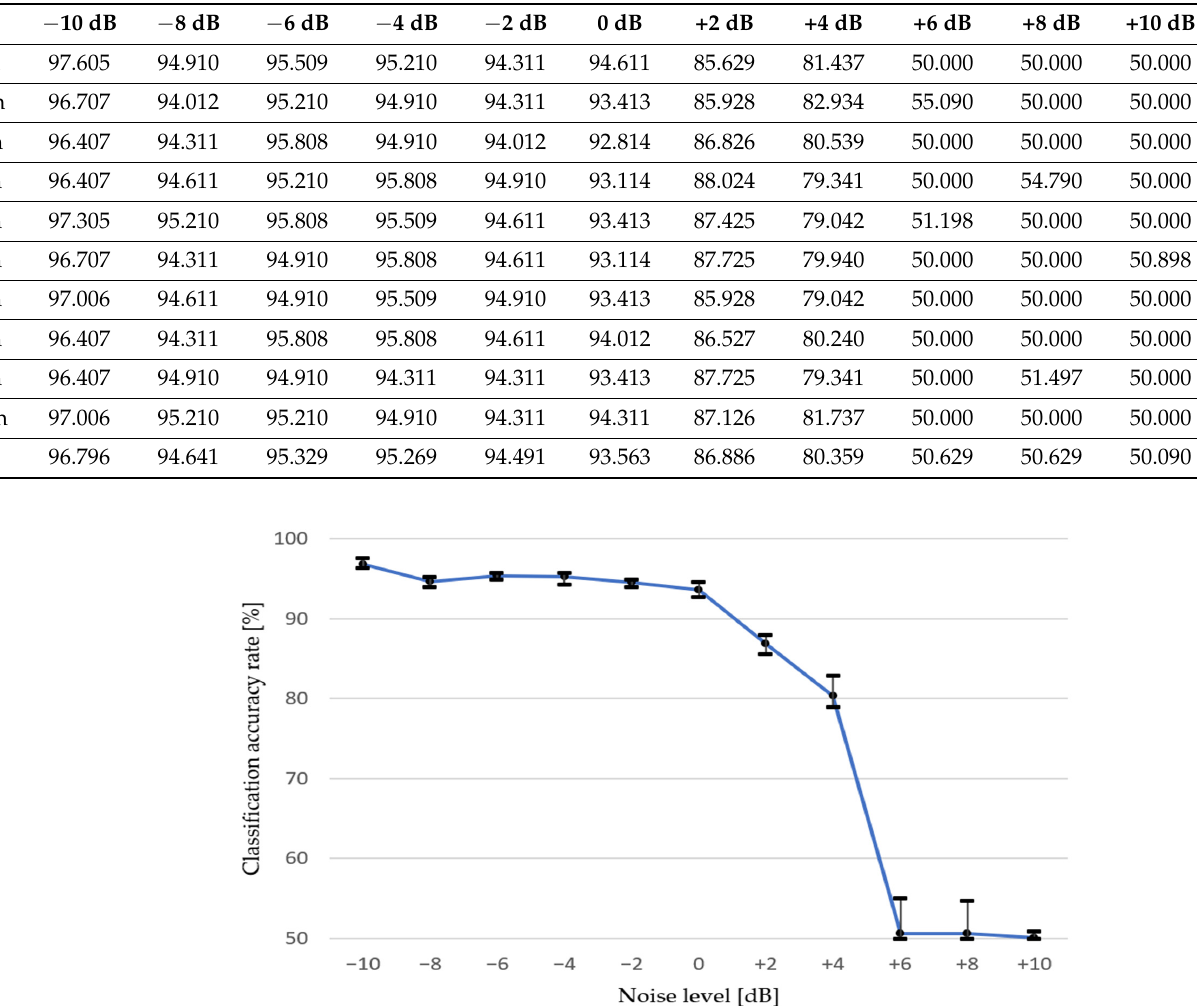
Figure 10. Trend of classification accuracy across all tested intensities of EN for data represented by spectrogram 1. Table 4. Obtained classification accuracies [%] for datasets of spectrogram 1. Table 5. Obtained classification accuracies [%] for datasets of spectrogram 2.